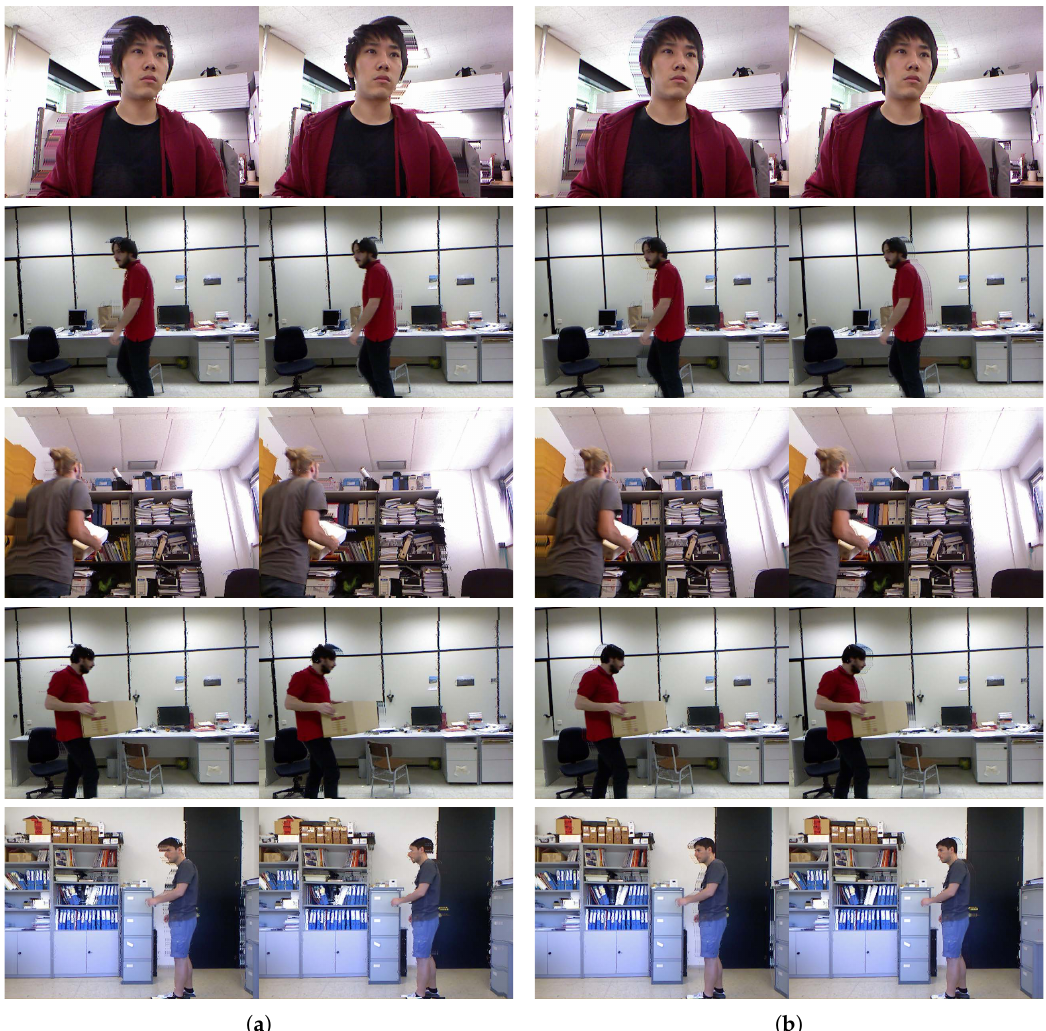
Figure 17. Comparison of the quality of the stereoscopic images. ( a , b ) are generated using original and enhanced depth images by the proposed method,